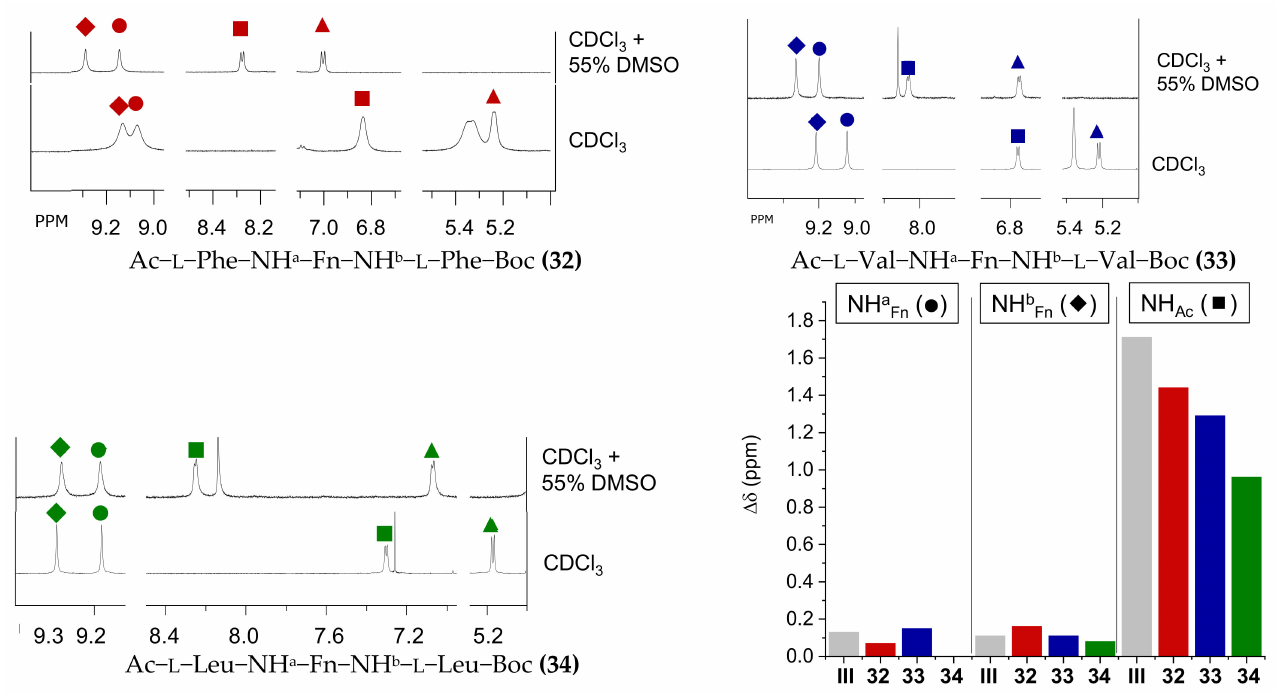
Figure 6. Changes in chemical shifts ( ∆ δ ) of NH Fn and NH Ac in peptides 32 – 34 in the presence of 55% d 6 -DMSO in CDCl 3 ( c = 25 mM, 298